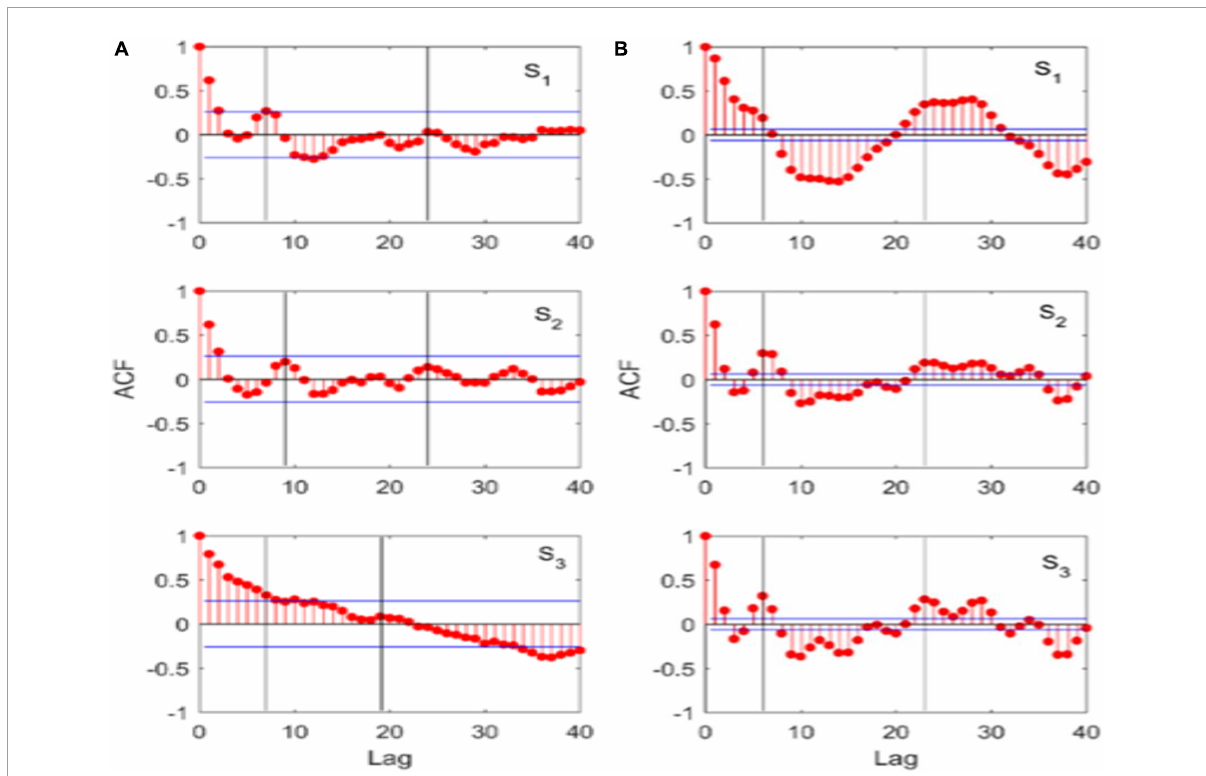
FIGURE3 Chaotic dynamics is observed for the northeast Arctic cod ( Gadus morhua ) based on empirical data and simulation data analyzes. (A) Autocorrelation function (ACF) of empirical data; (B) ACF of simulation data; body length class I ( S 1 ), class II ( S 2 ), and class III ( S 3 ). Blue line denotes significance threshold and the value in the middle of two blue lines can be considered not significantly different from